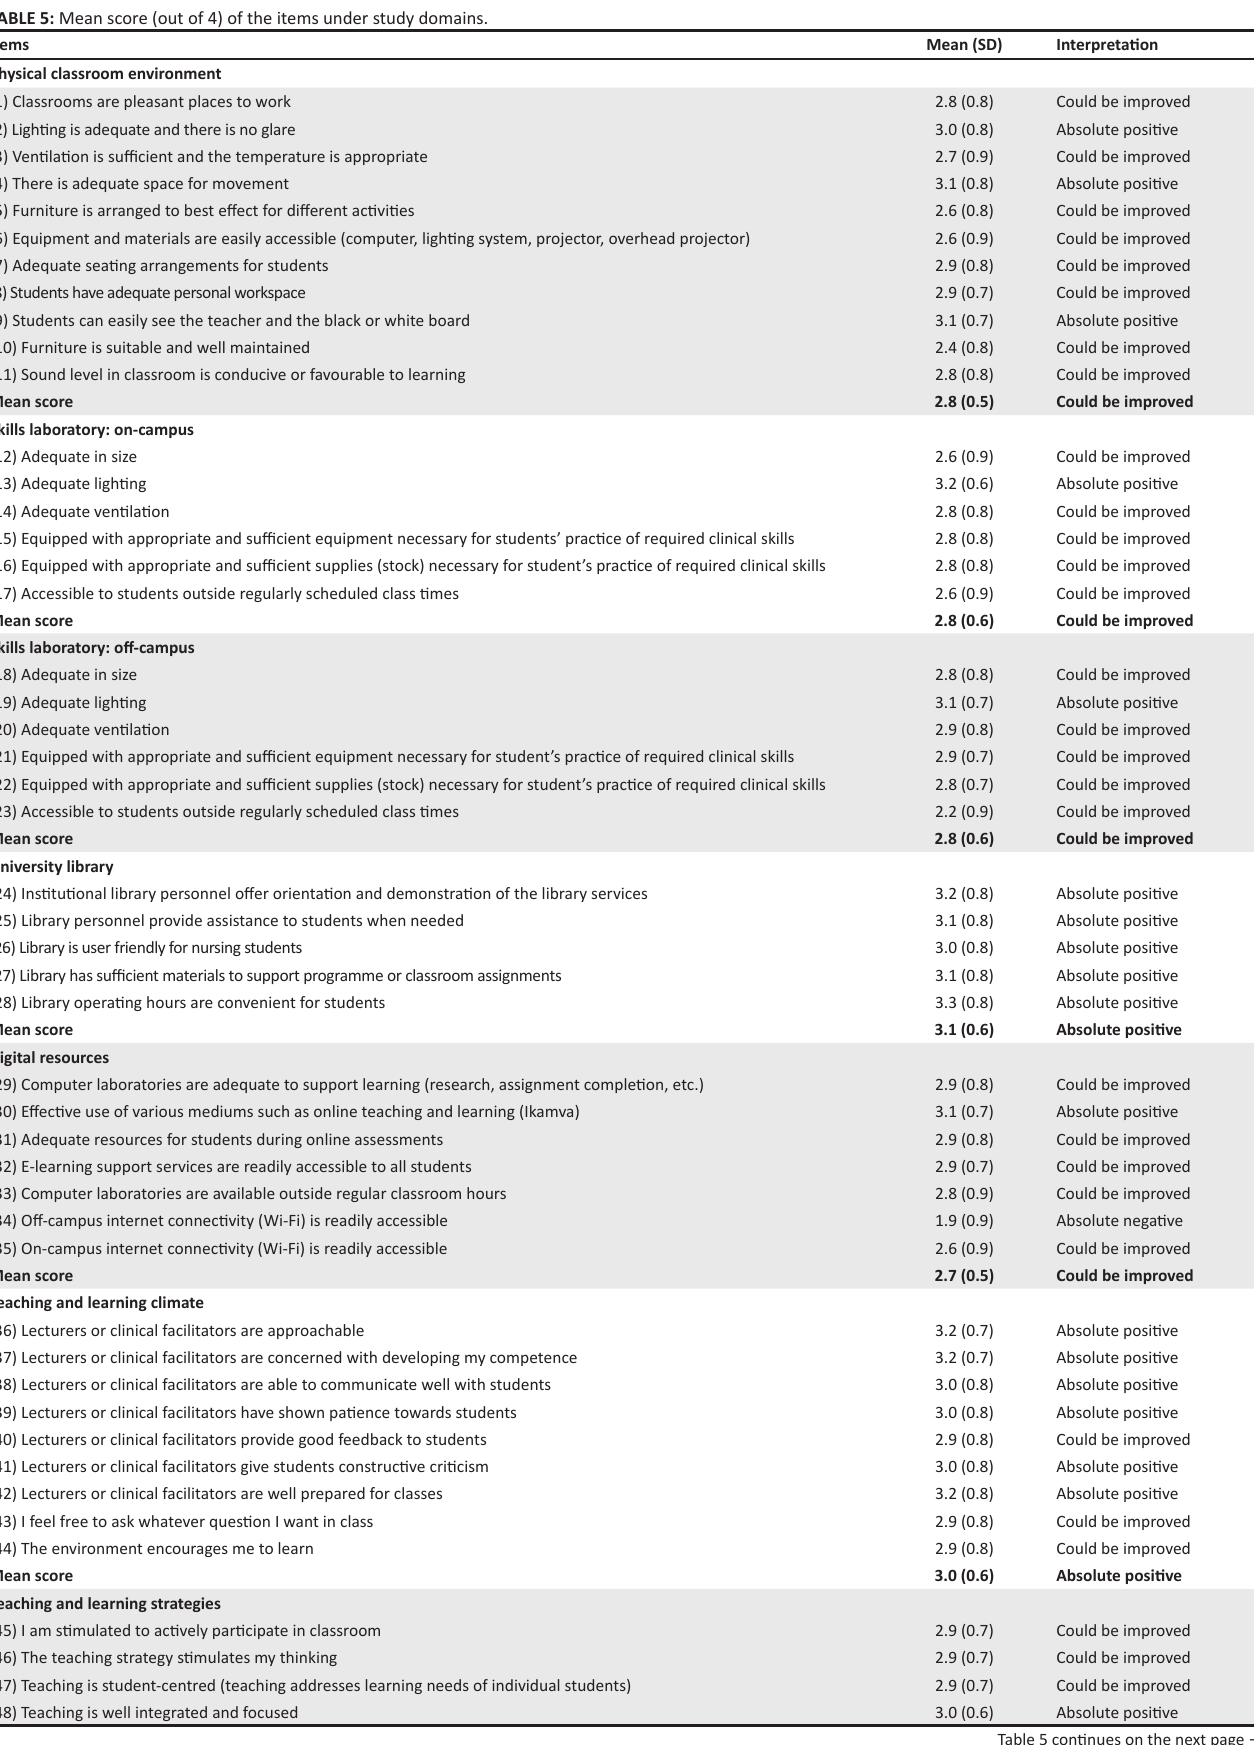
TABLE 5: Mean score (out of 4) of the items under study domains. Items Mean